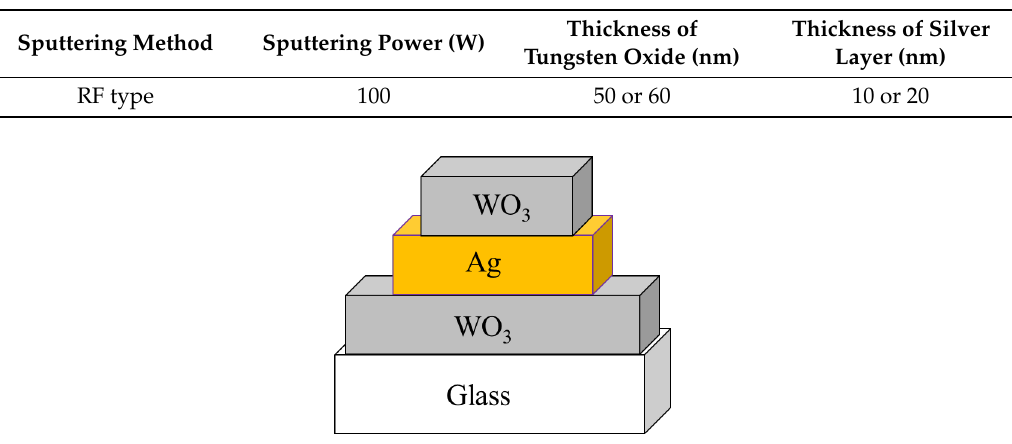
Figure 3. Three-layer transparent conductive film structure of WO 3 /Ag/WO 3 without metal electrodes.